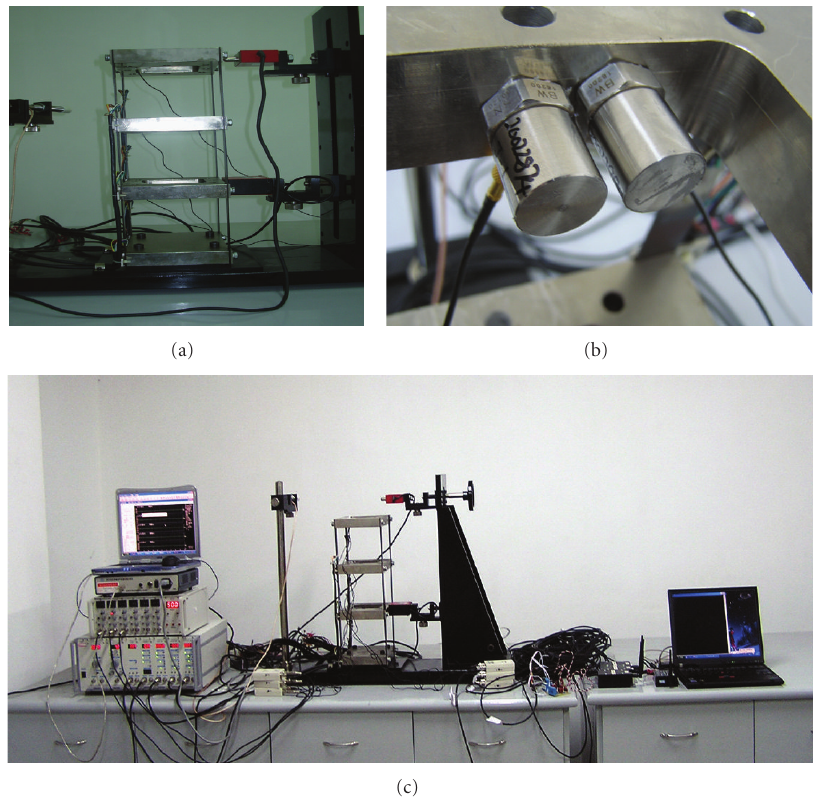
Figure 3: Test structure model with wireless sensing system.